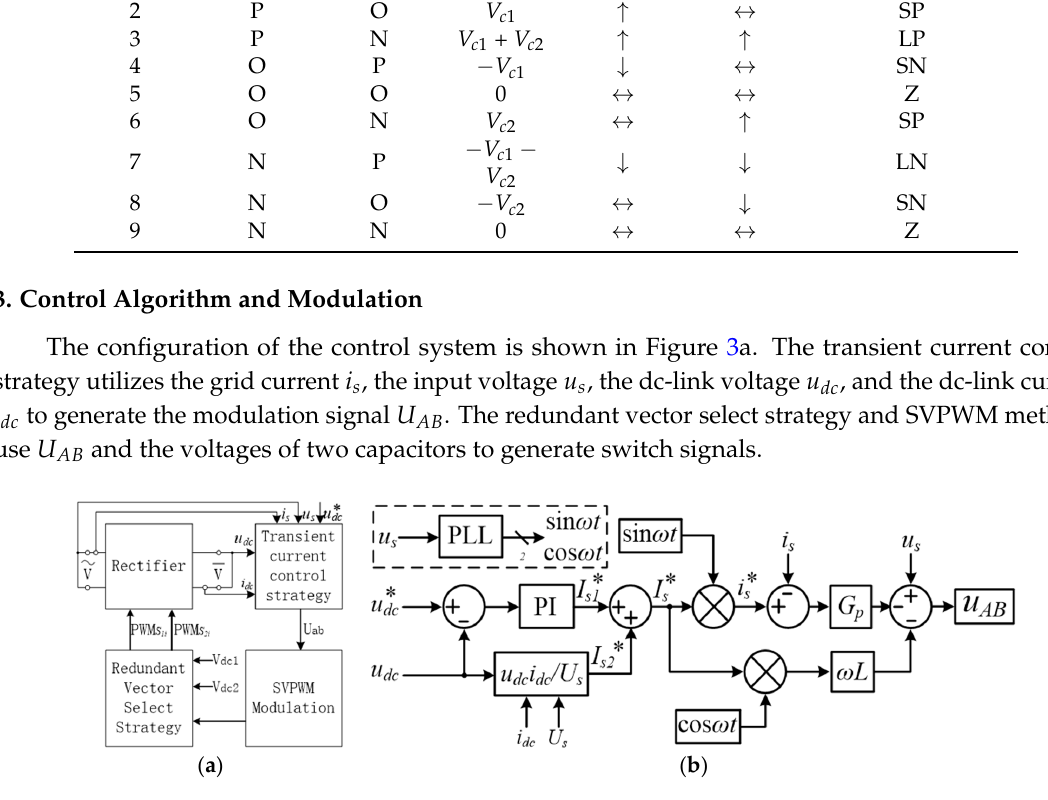
Table 1. Switch state and effect on two capacitors. ↑ : charge; ↓ : discharge; ↔ : no effect; Z: zero vector; SP: small positive vector; LP: large positive vector; SN: small negative vector; LN: large negative vector.